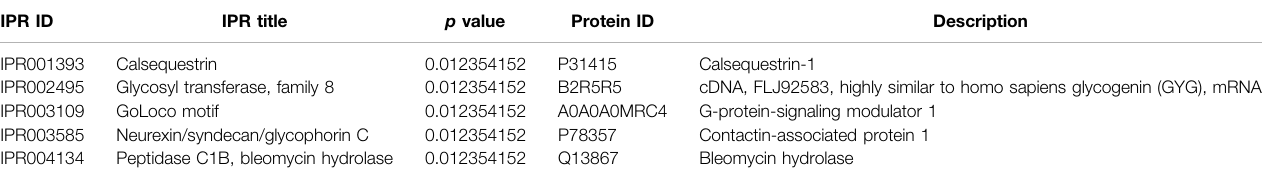
TABLE 3 | Representative fi ve enriched IPR terms of DEP.